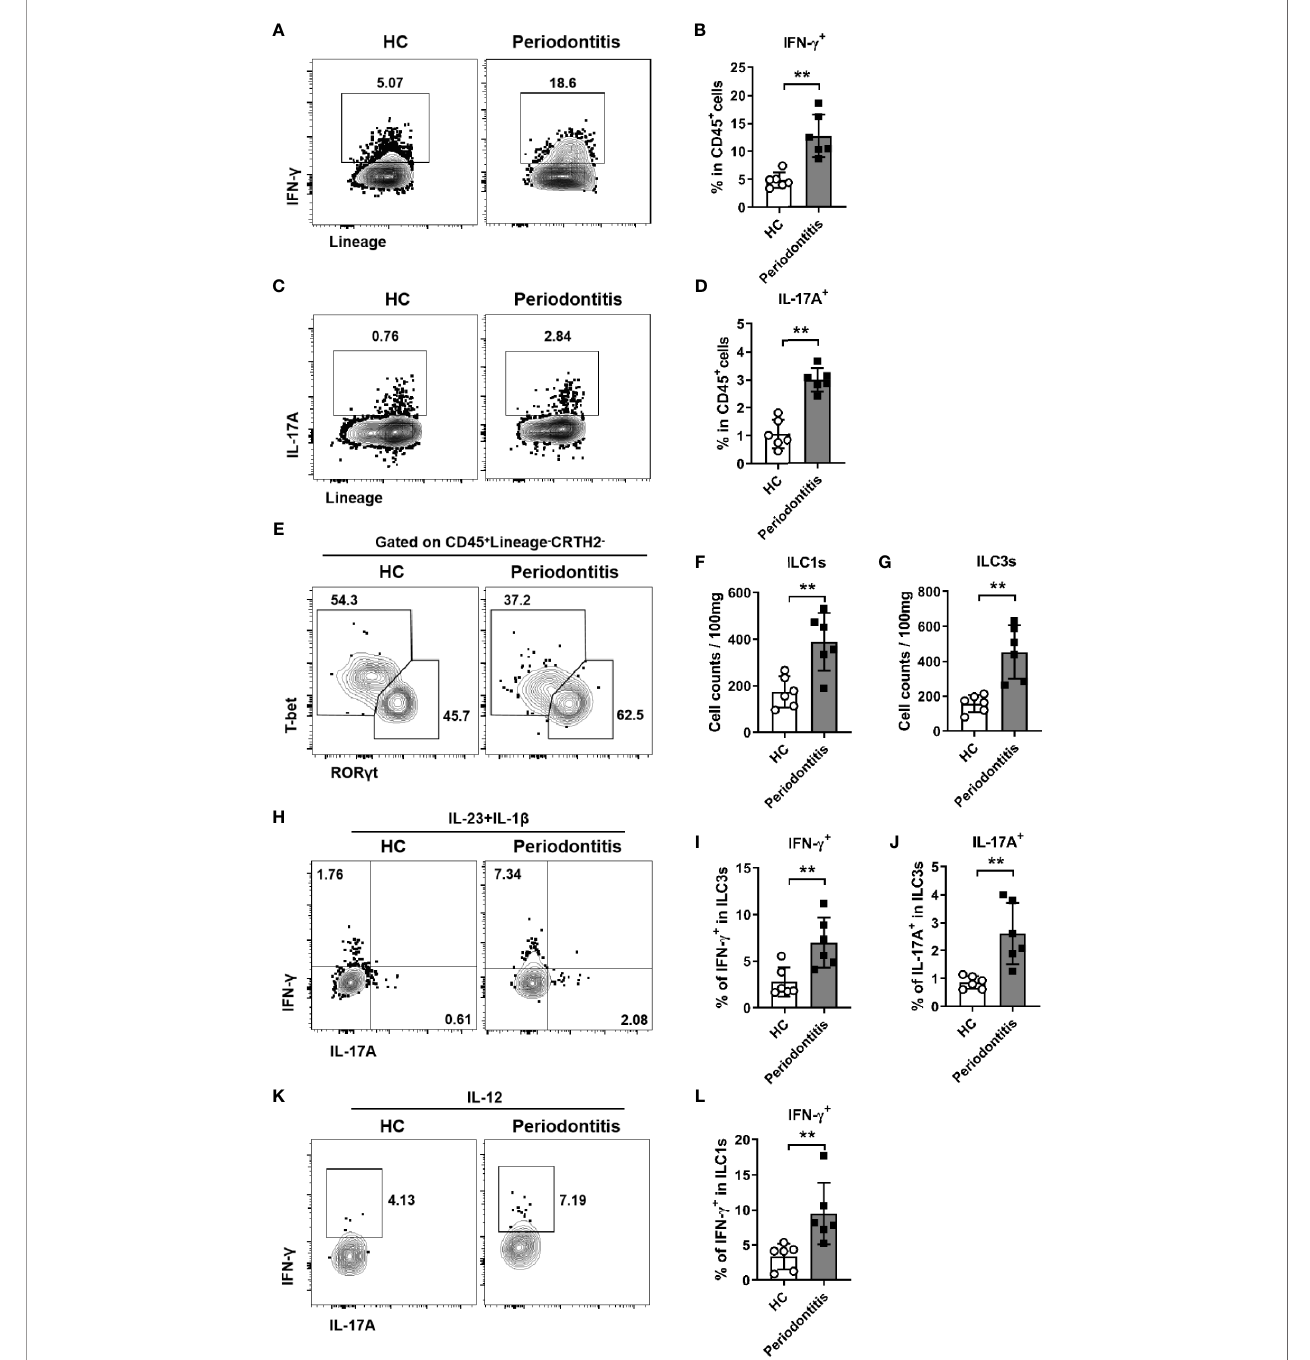
FIGURE 4 | Enhanced production of IFN- g and IL-17A by ILC1s/ILC3s in periodontal ligament of periodontitis patients. (A) Representative fl ow cytometry analysis of CD45 + immune cells stimulated with PMA plus ionomycin and stained for intracellular IFN- g . (B) Frequencies of IFN- g + cells in CD45 + cells from healthy individuals and periodontitis patients. (C) Representative fl ow cytometry analysis of CD45 + immune cells stimulated with PMA plus ionomycin and stained for intracellular IL-17A. (D) Frequencies of IL-17A + cells in CD45 + cells from healthy individuals and periodontitis patients. (E) Representative fl ow cytometry analysis of ROR g t and T-bet in CD45 + Lineage - CRTH2 - cells. Absolute cell numbers (per 100mg tissue) of (F) ILC1s (T-bet + ) and (G) ILC3s (ROR g t + ) in periodontal ligament from healthy individuals and periodontitis patients. (H) Representative fl ow cytometry analysis of intracellular IL-17A and IFN- g in ILC3s (gated on CD45 + Lineage - CRTH2 - ROR g t + cells) stimulated with IL-23 and IL-1 b . Frequencies of (I) IFN- g + cells and (J) IL-17A + cells in ILC3s from healthy individuals and periodontitis patients. (K) Representative fl ow cytometry analysis of intracellular IFN- g in ILC1s (gated on CD45 + Lineage - CRTH2 - T-bet + cells) stimulated with IL-12. (L) Frequencies of IFN- g + cells in ILC1s from healthy individuals and periodontitis patients. n = 6 for each group. **p <